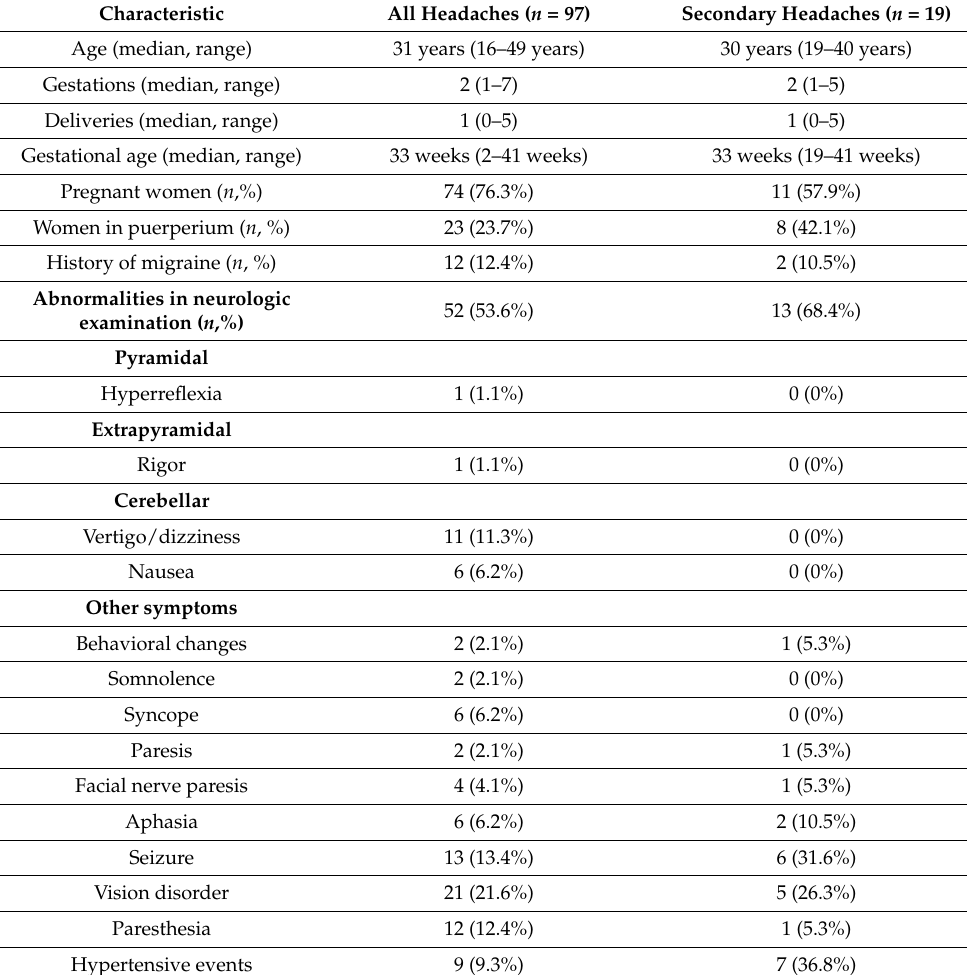
Table 1. Patients’